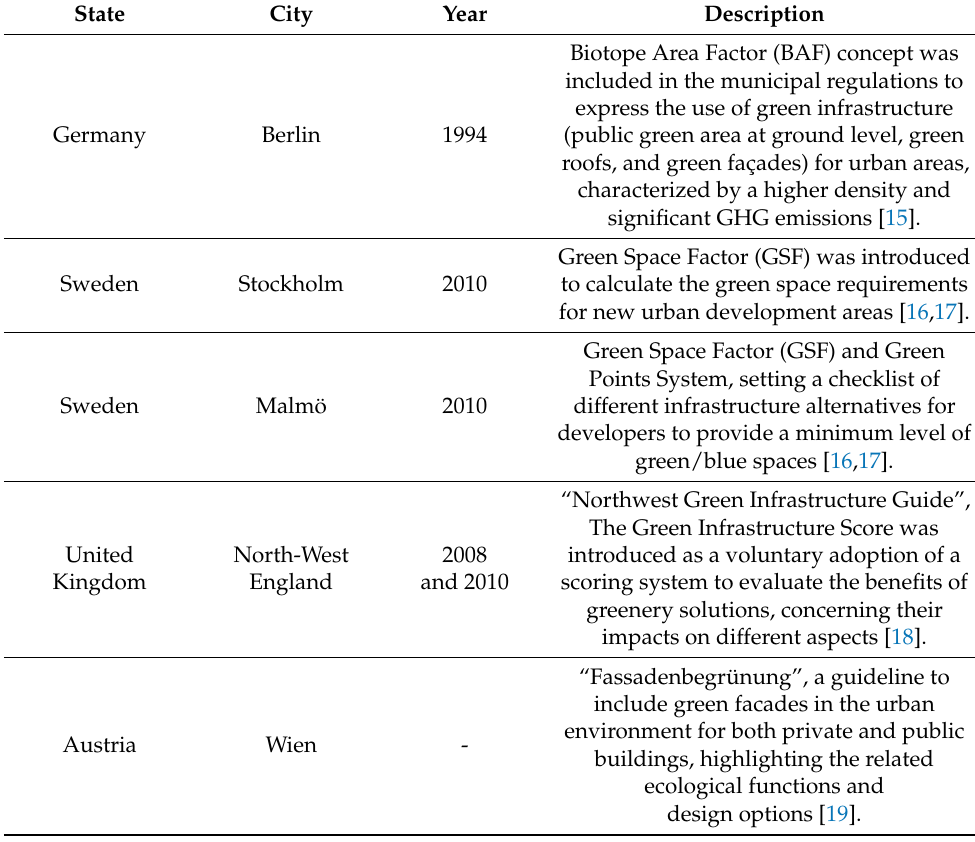
Table 1. Local initiatives promoted by different European